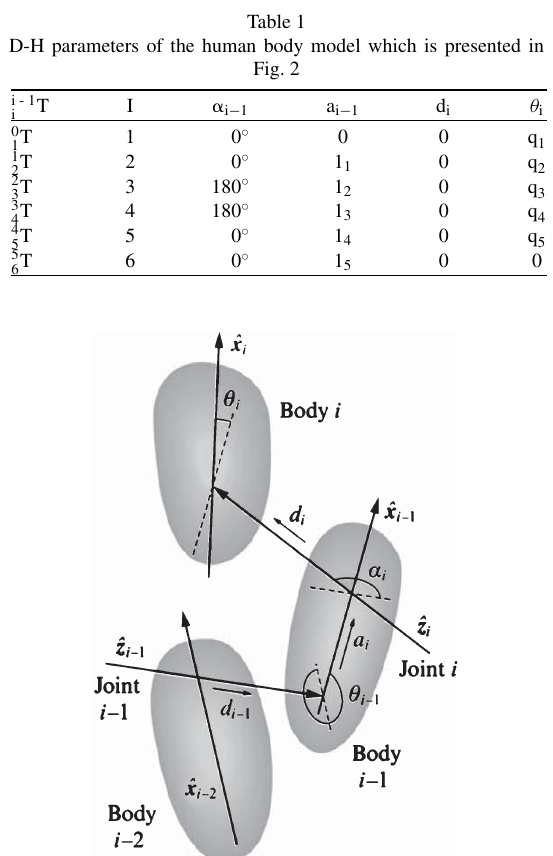
D-H parameters of the human body model which is presented in